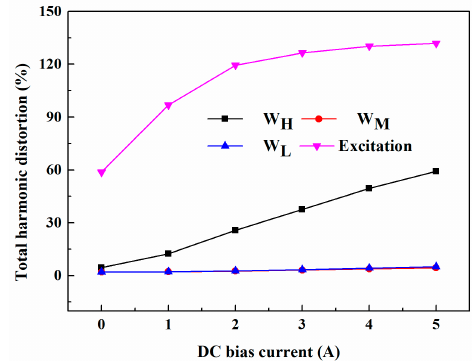
Figure 12. THD of excitation and winding currents.